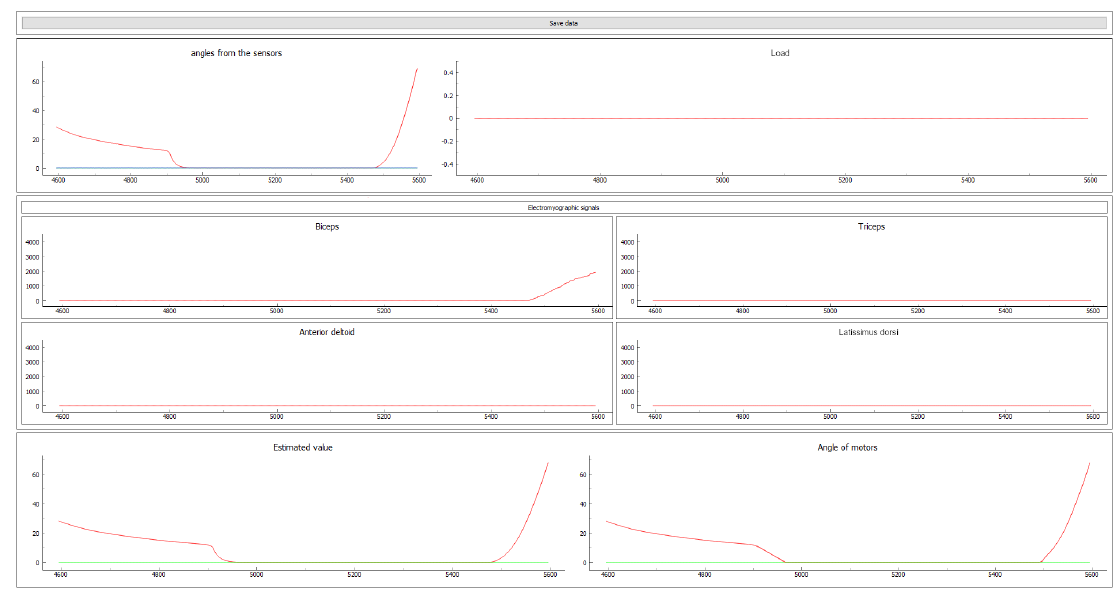
Figure 6. Software interface developed for real-time signal analysis.